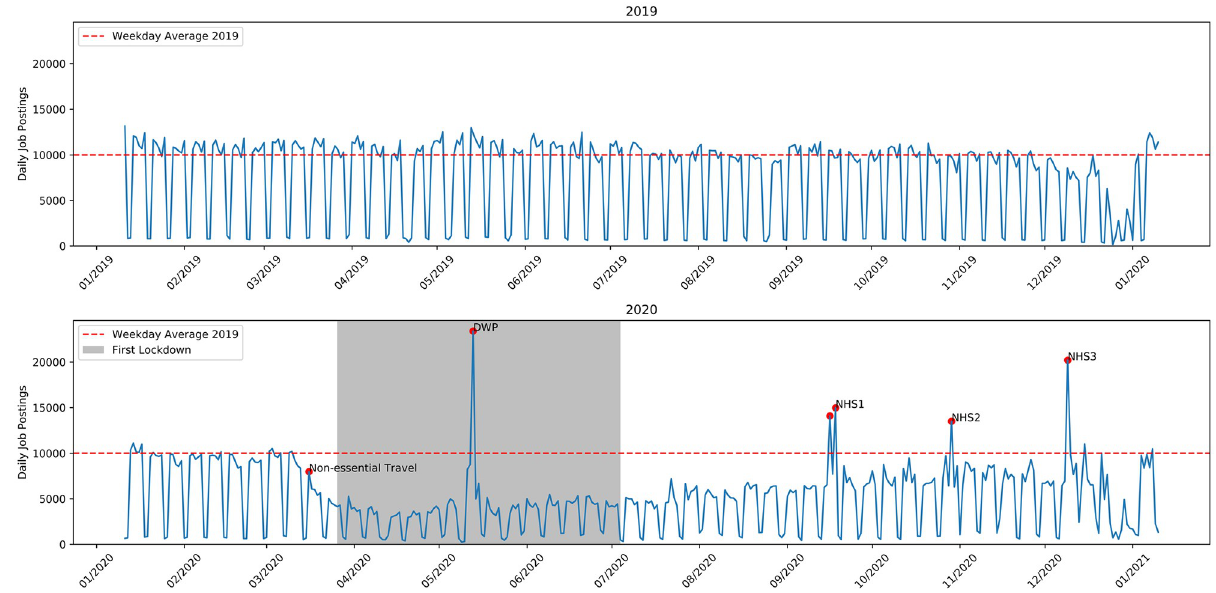
Fig 1. Daily job postings on Reed over the study period. The periodic dips correspond to weekends and public holidays. Some key dates are indicated and discussed in the text.